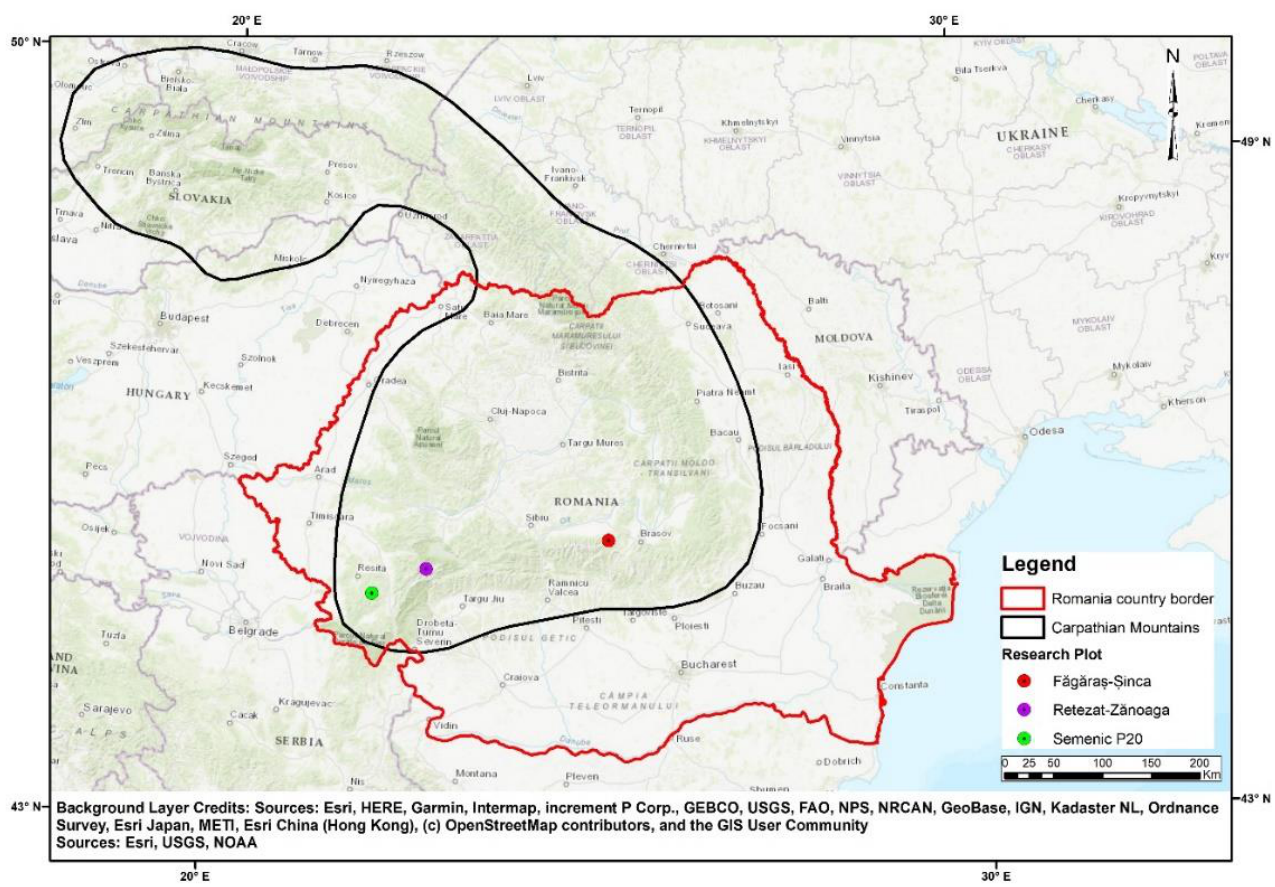
Figure 1. Research plot location. Table 1. Main characteristics of the research